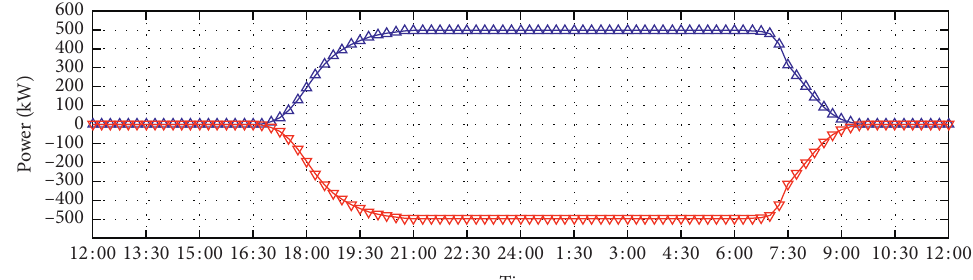
Figure 15: Chart of power range of virtual energy storage with electric vehicle